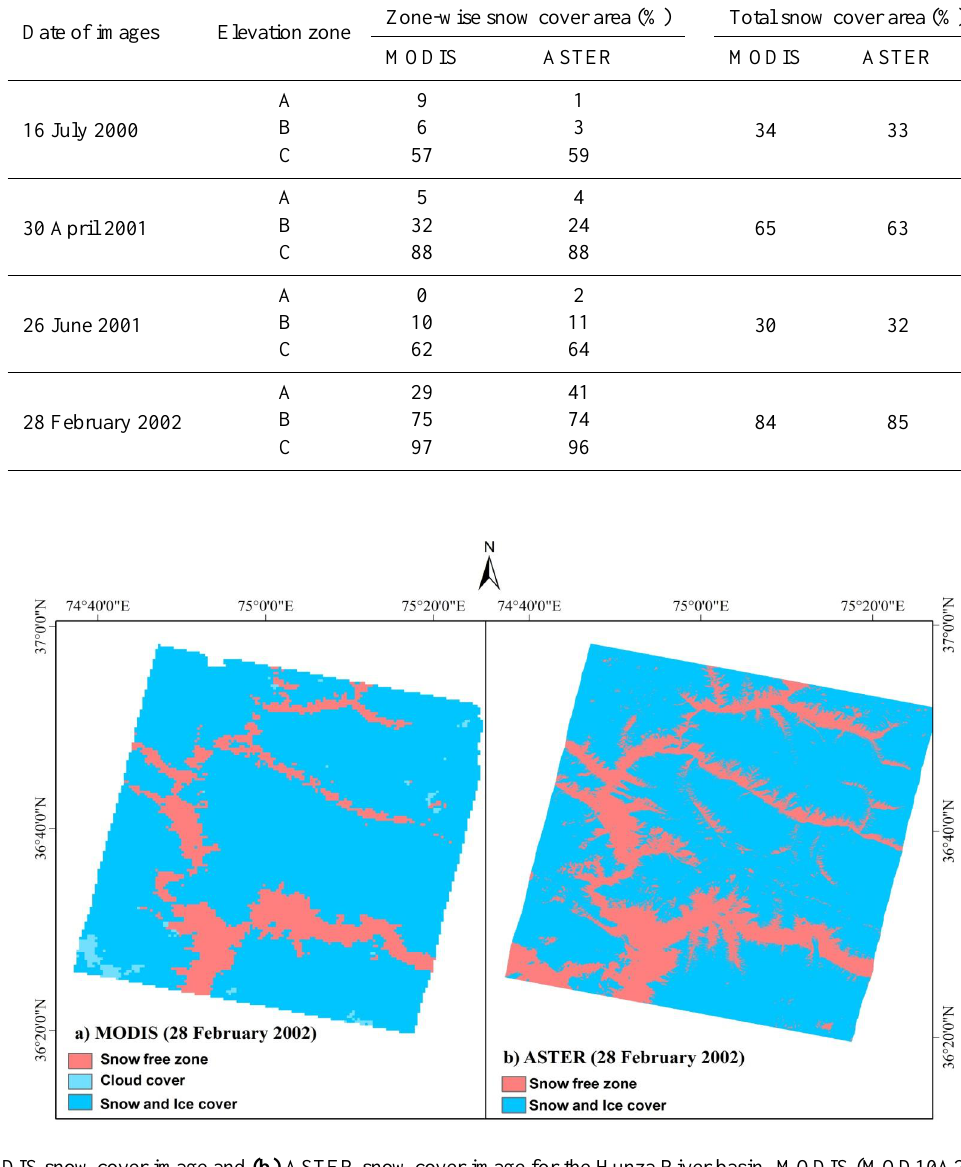
Fig. 4 (a) MODIS snow cover image and (b) ASTER snow cover image for the Hunza River basin. MODIS (MOD10A2) snow product is 8-day average data and the time span of this particular image presented here is from 25 th February 2002 to 04 th March 2002.